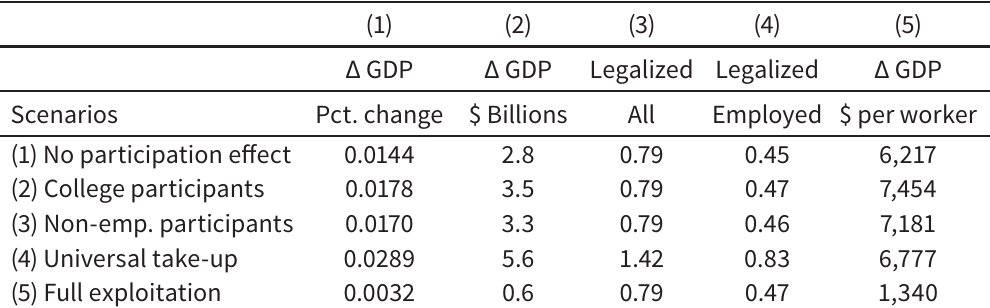
Effects of DACA on